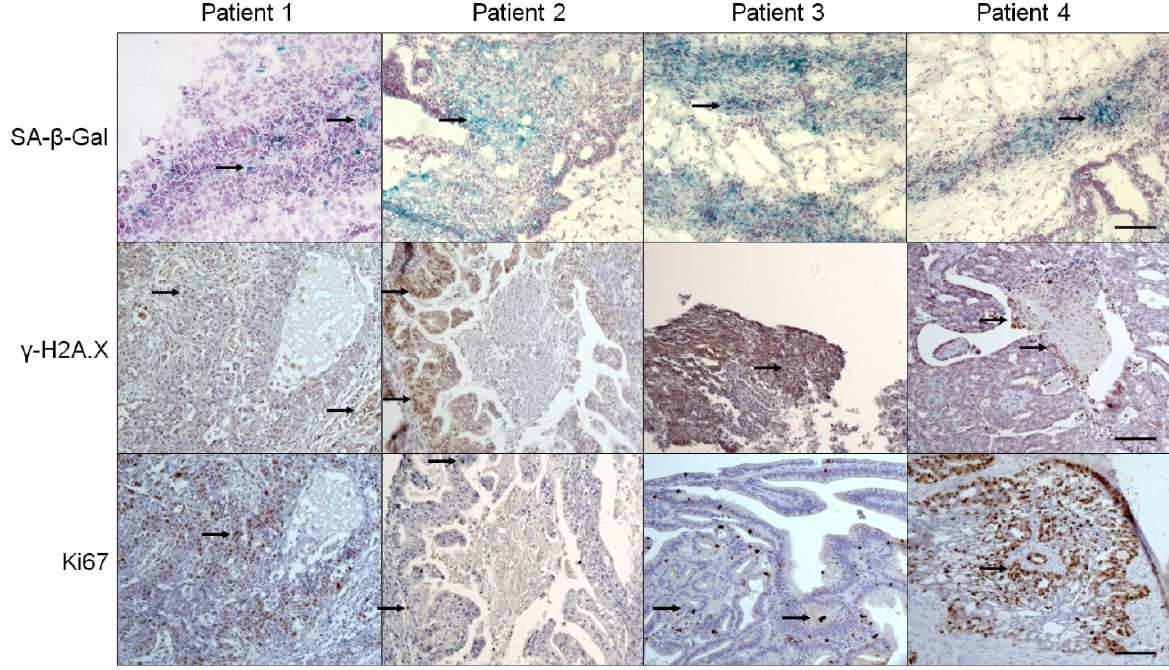
Figure 1. Representative staining of SA- β -Gal (green), γ -H2A.X (brown), and Ki67 (brown) showing differences in the magnitude of cellular senescence in tumors from different ovarian cancer patients. The arrows indicate exemplary positive reactions. Scale bars = 100 μ m.